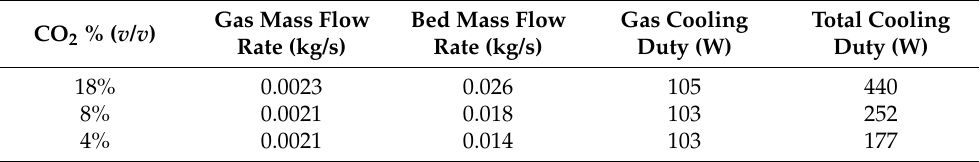
Table 6. Simulated moving bed energy duties and bed flow rate for various CO 2 concentrations using updated mass flow balance model (Equation (18)).